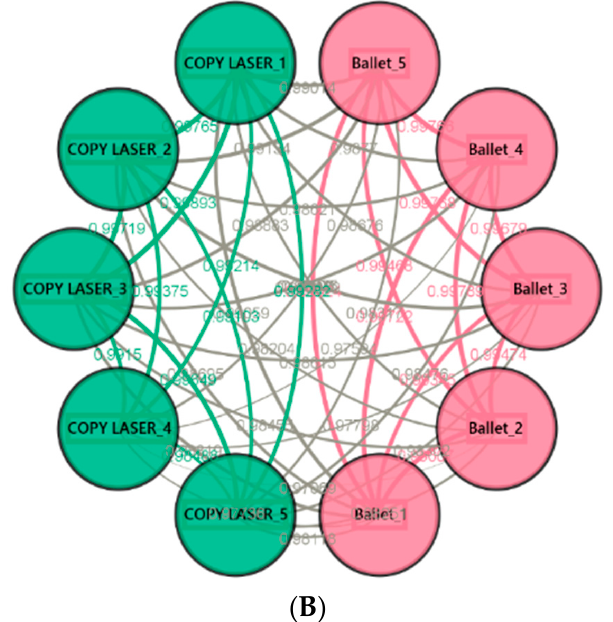
Figure 2. Test 2 visualization of Pair_1 document ( A ) and Pair_2 documents ( B ).